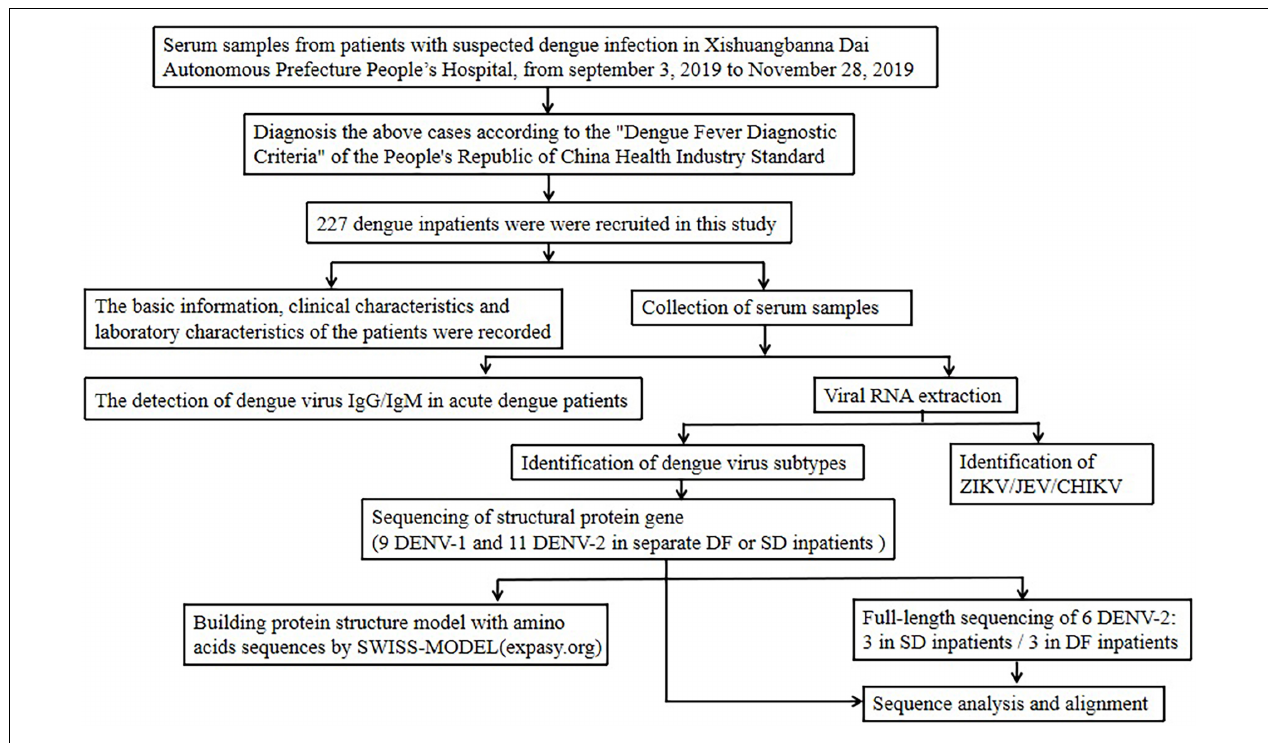
FIGURE 2 | Study design and